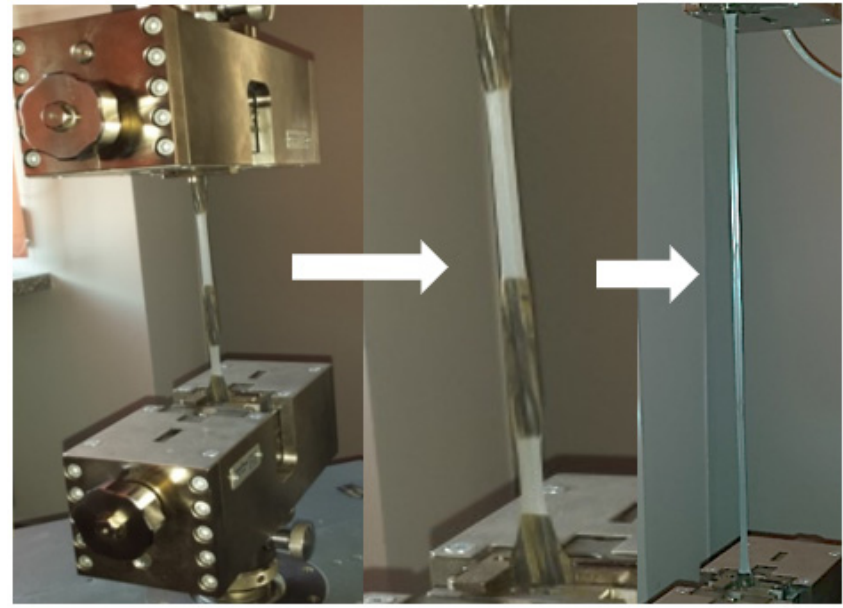
Figure 7. View of the sample during tensile test.